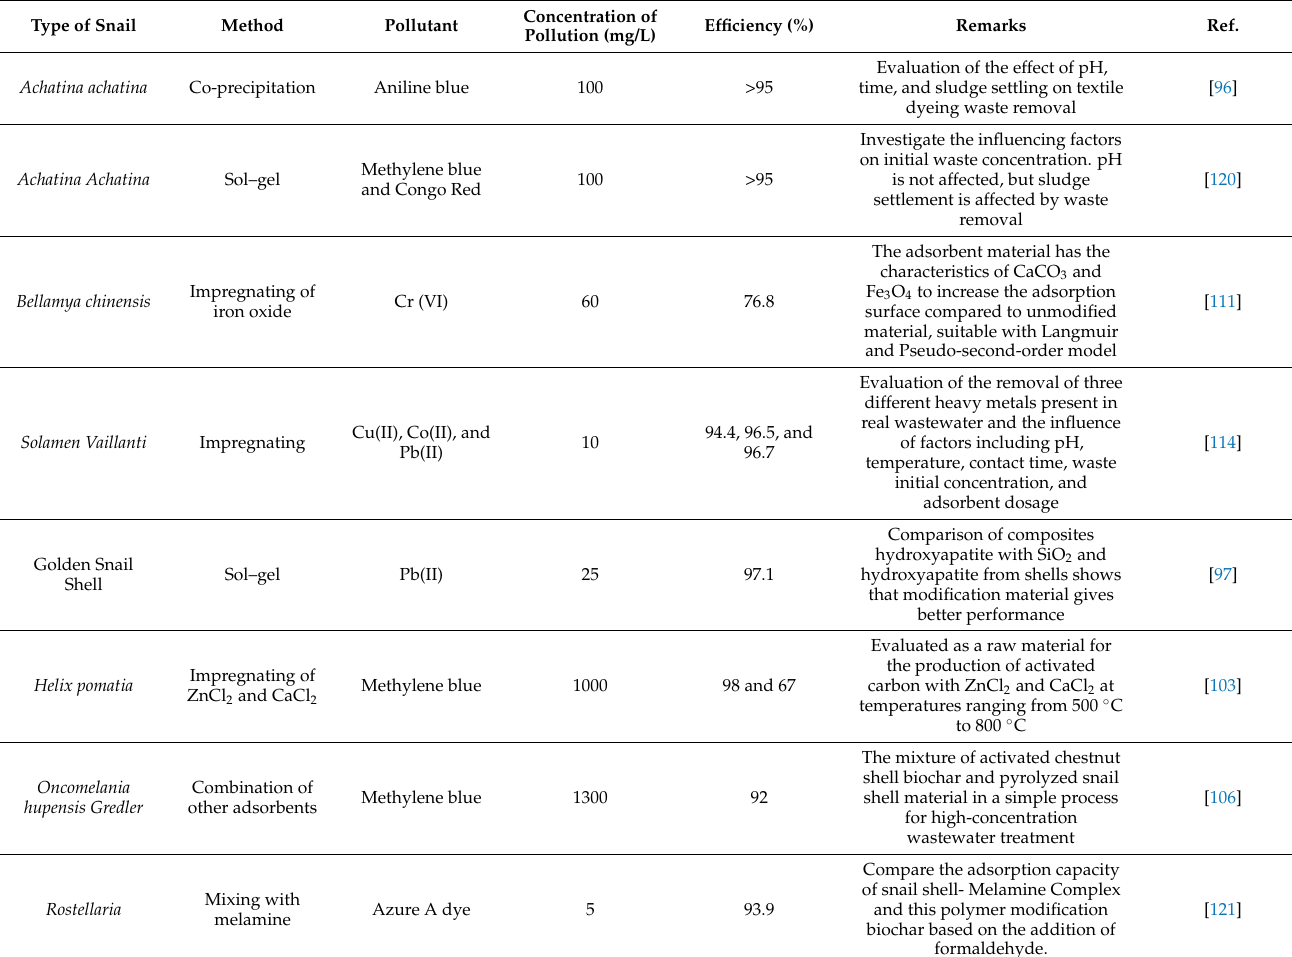
Table 4. Waste treatment efficiency of shell materials with different